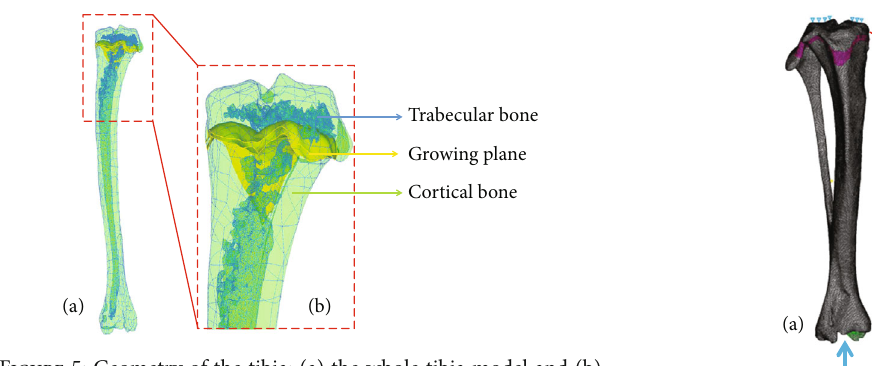
Figure 4: Cyclic dynamic compressive load: (a) the input waveform and (b) the process of 6-step loading regime; blue arrow: the loading waveform between the fi rst and the second loading steps.